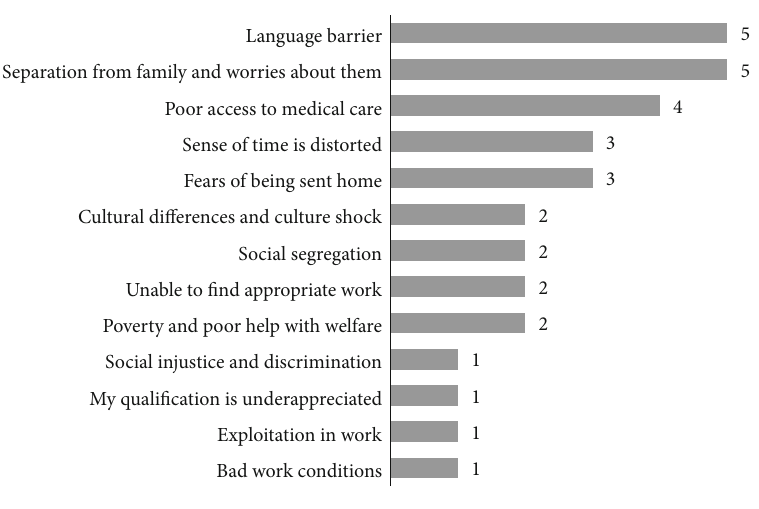
Figure 1: Median of scores of items of the LDSR in a descending order. (1) Not a problem at all, (2) mild problem, (3) problem, (4) serious problem, and (5) very serious